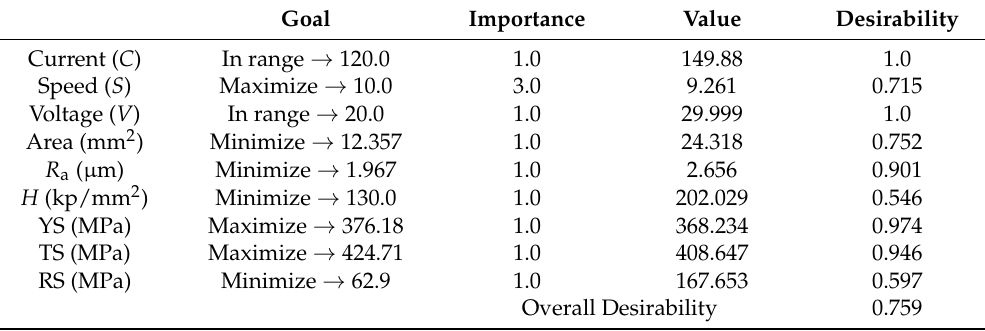
Table 12. The third criterion considered: productivity of manufacturing based on the welding speed.